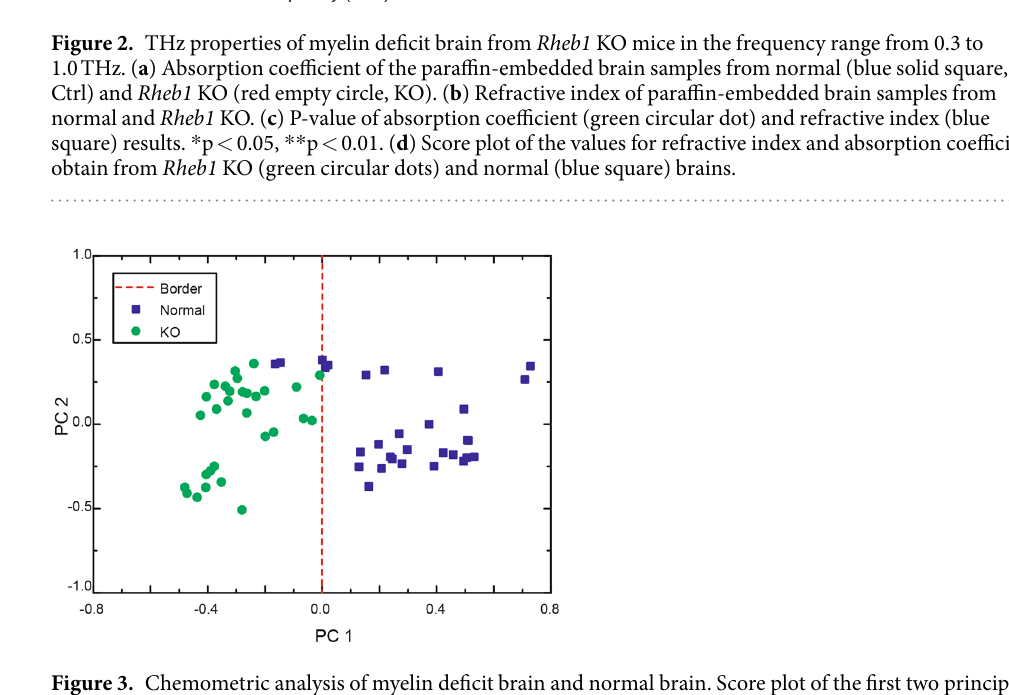
naked eye (Fig. 4e). We positioned the THz wave focus (the origin of an imaginary x-y plot) close to the center of ROI. Another five points were equally spaced in 500 μ m from the origin on either x or y axis. Generally, the average amplitudes of ROIs in EAE brain were higher than those in normal brain (Fig. 4f). We calculated the peak-to-peak values of the THz pulses and normalized them to the average value of normal monkey brain. The normalized amplitudes of EAE monkey were significantly increased (insert of Fig. 4f). However, PCA-tdTHz